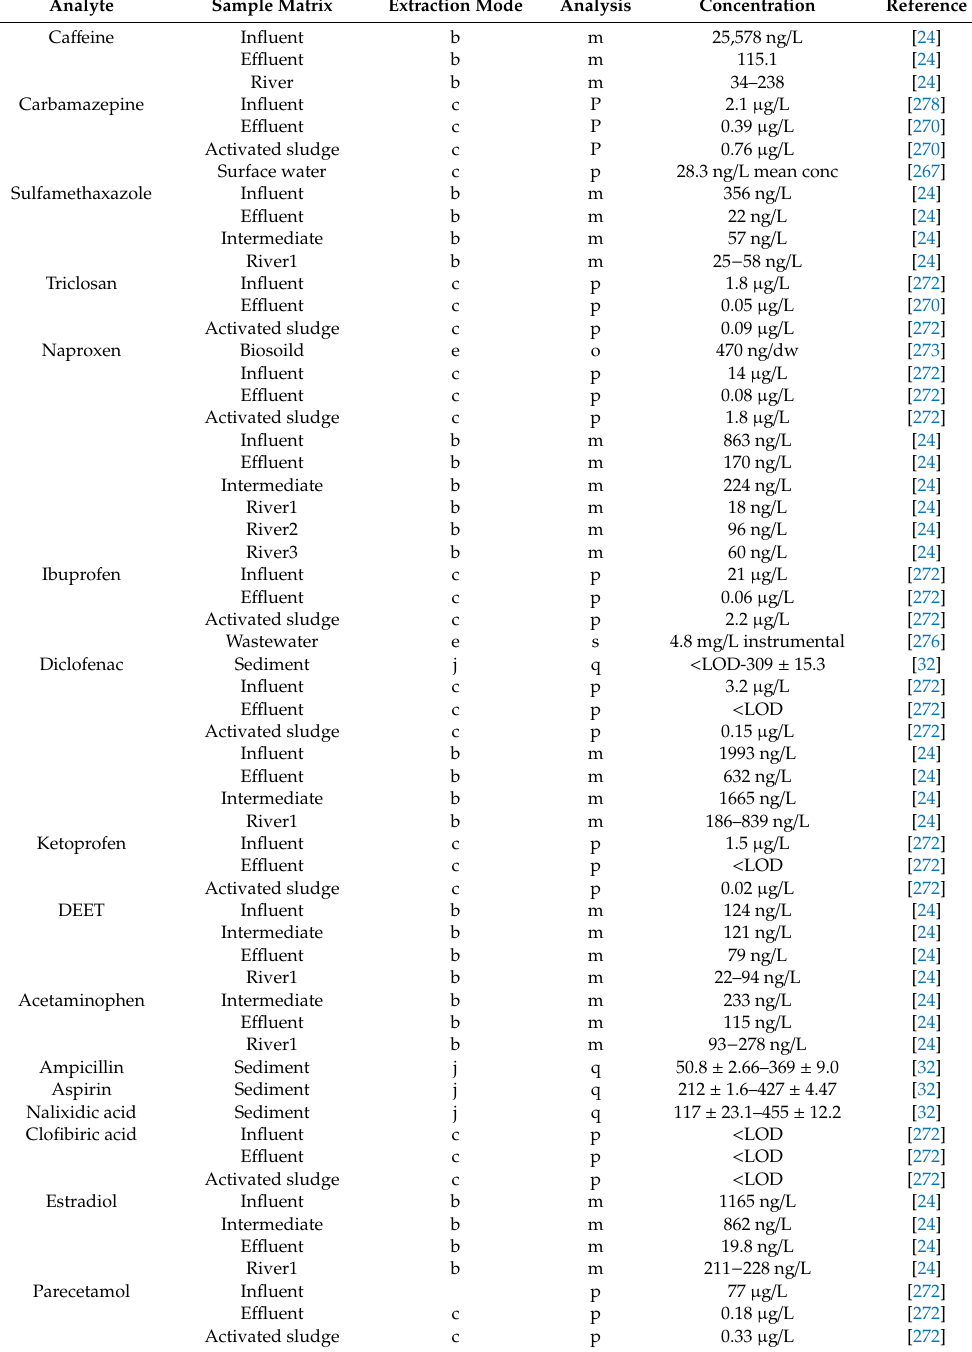
Table 1. Extraction techniques of various pharmaceuticals and personal care